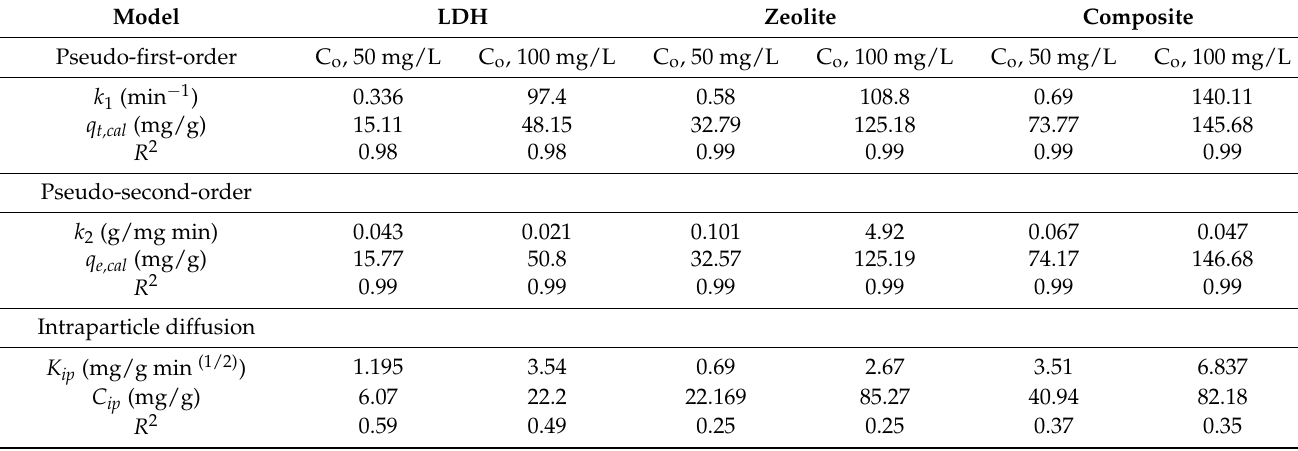
Table 5. Kinetic parameters for the pseudo-first-order, pseudo-second-order, and intraparticle diffusion models of MB adsorption onto the LDH, zeolite, and zeolite/LDH